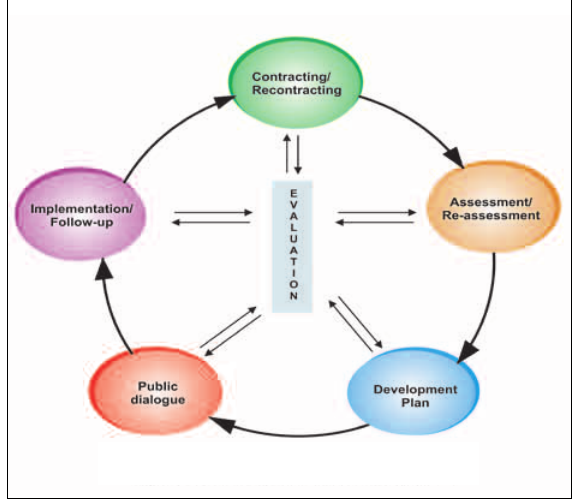
FIGURE 1 Competence Executive Coaching